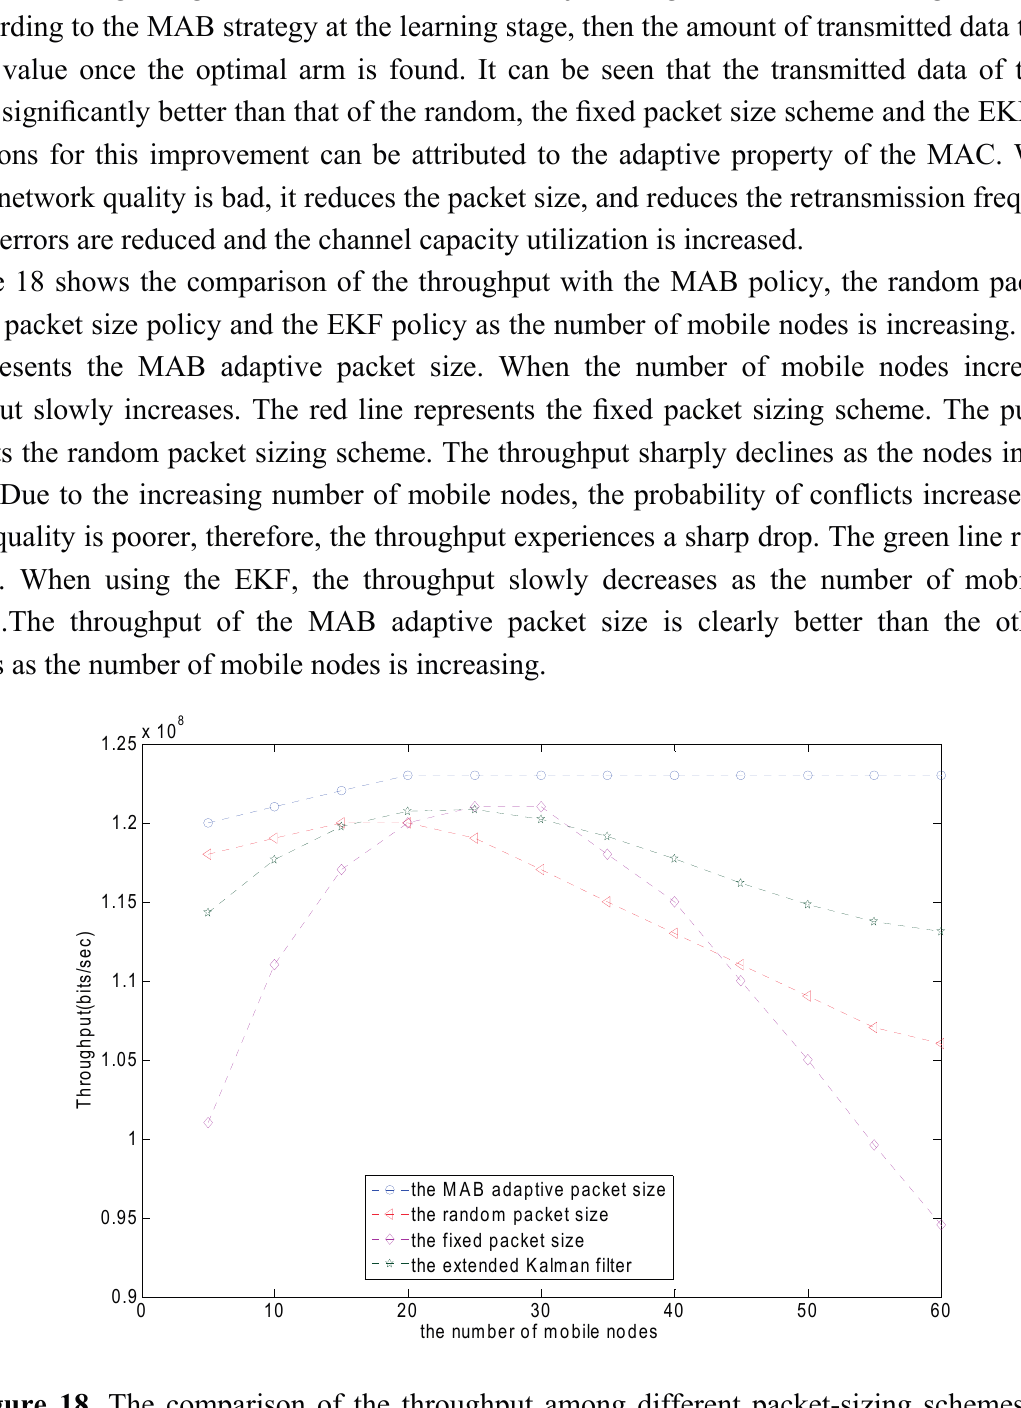
Figure 18. The comparison of the throughput among different packet-sizing schemes as the number of mobile nodes is